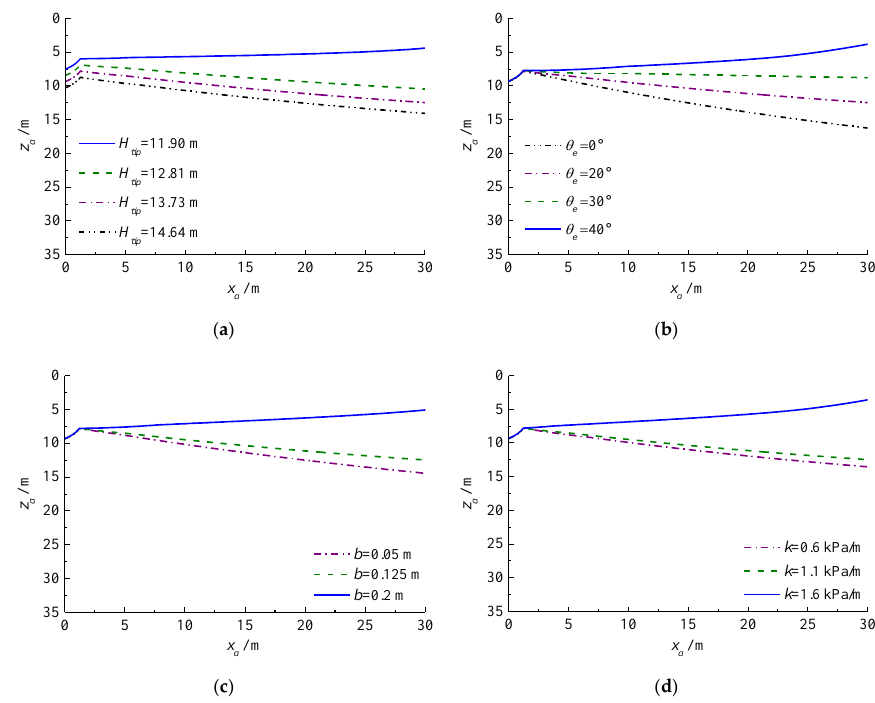
Figure 19. Influence of parameters on the trajectory of OMNI-Max anchor in clay: ( a ) Effect of H tip ; ( b ) Effect of θ e ; ( c ) Effect of b ; ( d ) Effect of k .